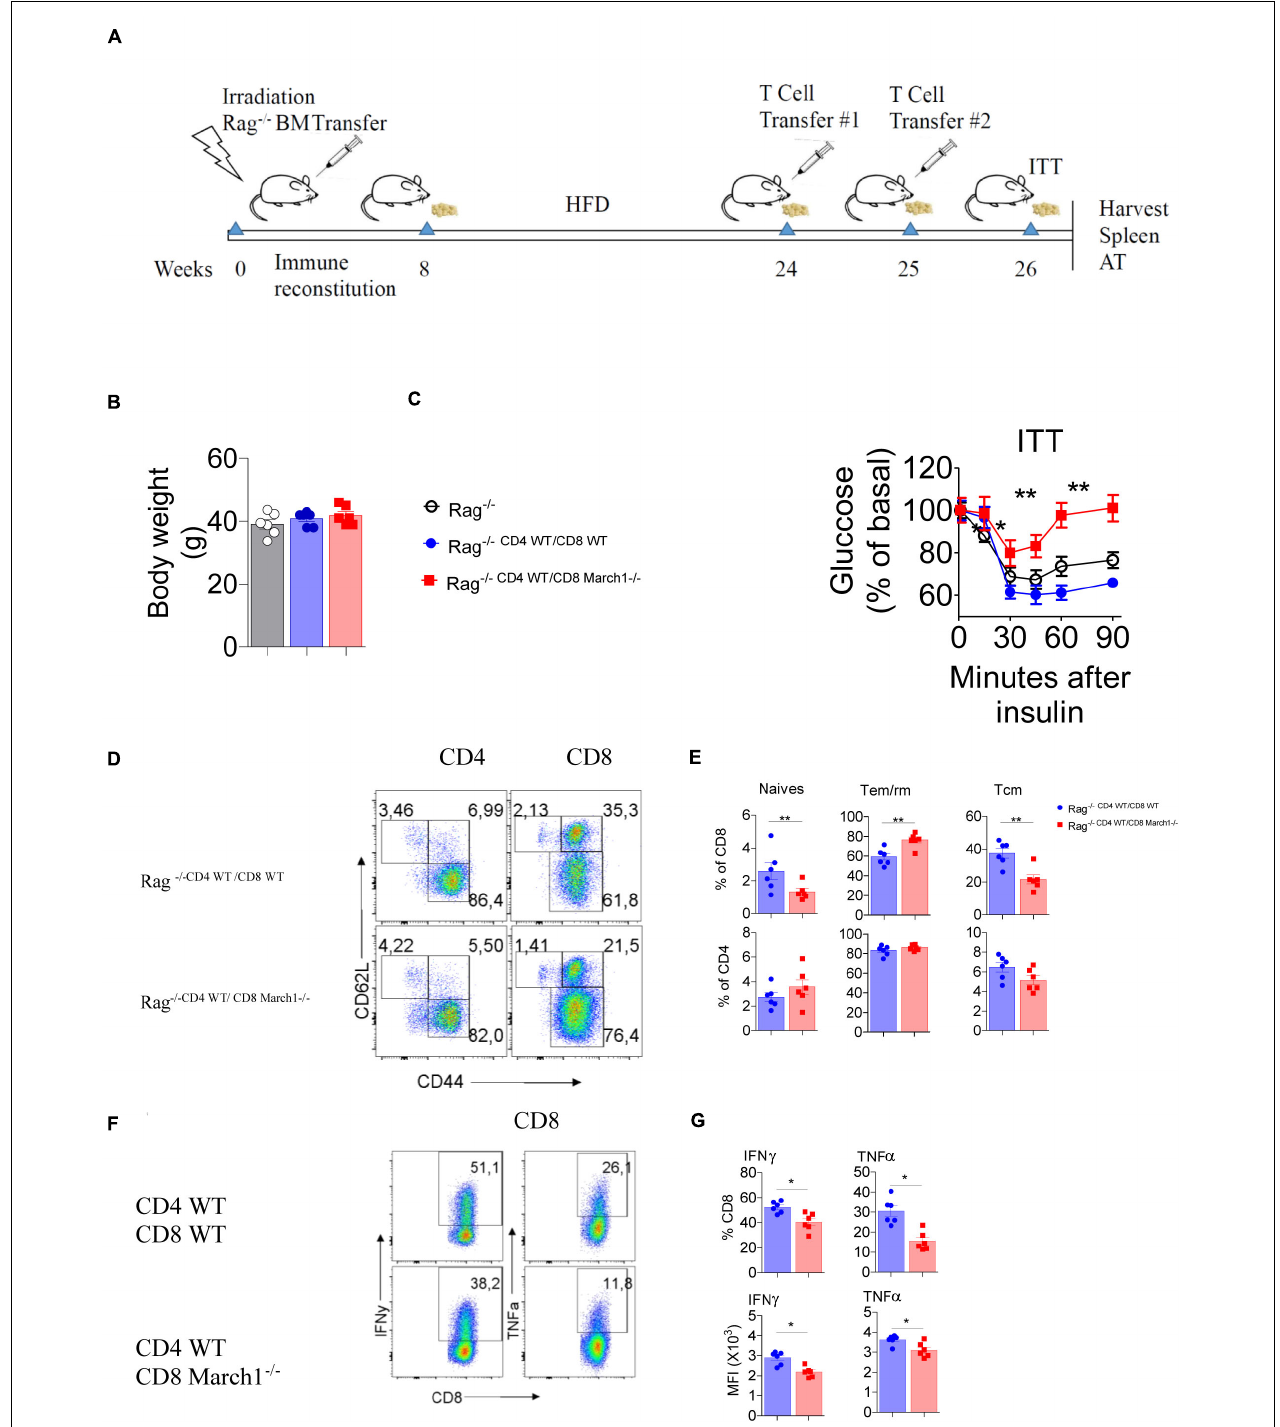
FIGURE 6 | Transfer of CD8 + T cells lacking March1 to Rag KO mice exacerbates IR. In order to generate immune cell Rag-deficient mice, 6 week old WT mice were lethally irradiated and received an i.v injection of bone marrow cells from full body Rag deficient mice. After 8 weeks of reconstitution, Rag KO BMC were fed CD or HFD for 16 weeks. At the end of this feeding period, mice having similar body weight (C) were injected with sorted 5 × 10 6 CD8 + T cells from 6 to 8 week old March1 -/- or WT control in combination with 5 × 10 6 CD4 + T cells from WT mice according to the chronology showed in panel (A) . T cell-injected and non-injected Rag KO mice (B) were submitted to an ITT (C) . SVF cells from T cells-injected Rag KO mice were analyzed by flow cytometry for T cell proportions and phenotype. Representative dot plots (D) and the proportions (E) of naïve, Tem/rm and Tcm CD4 + and CD8 + T cells. Representative dot plots (F) , the proportions of INF-y and TNF-a producing CD8 + T cells (G-top) with the MFI (G-bottom) of these cytokines. ∗ P < 0.05 and ∗∗ P < 0.01.